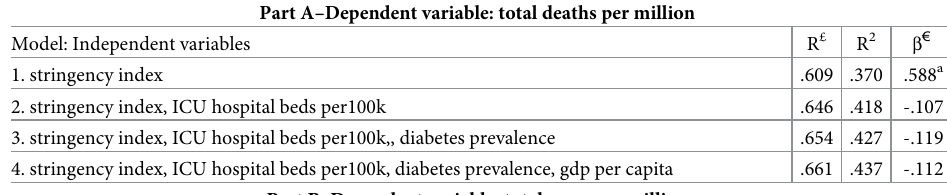
Table 2. Stepwise � multiple regression for covid-19 cases and